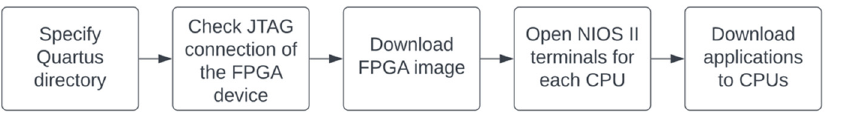
Figure 16. The mechanism of memory assignment.